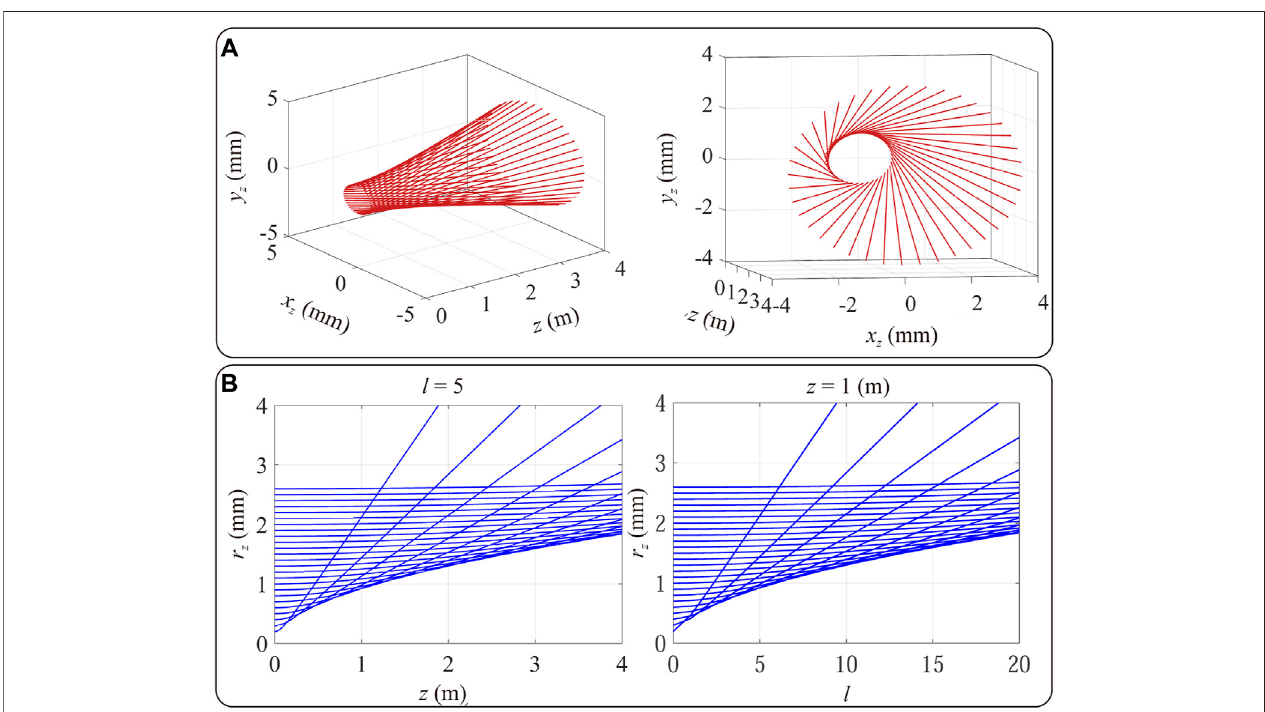
FIGURE 2 | Simulated propagation properties of light rays in free space for a vortex beam based on the ray-tracing method. (A) Distributions of light rays in three- dimensionalspacefordifferentviews. (B) Relationshipbetweentheparameter r z andthepropagationdistance z inthecaseof l =5(left),andtherelationshipbetweenthe parameter r z and the topological number l in the case of z = 1 m (right).